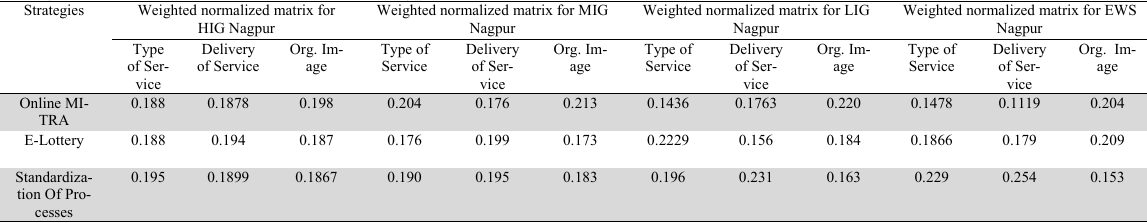
Weighted normalized matrix for Nagpur Board Strategies